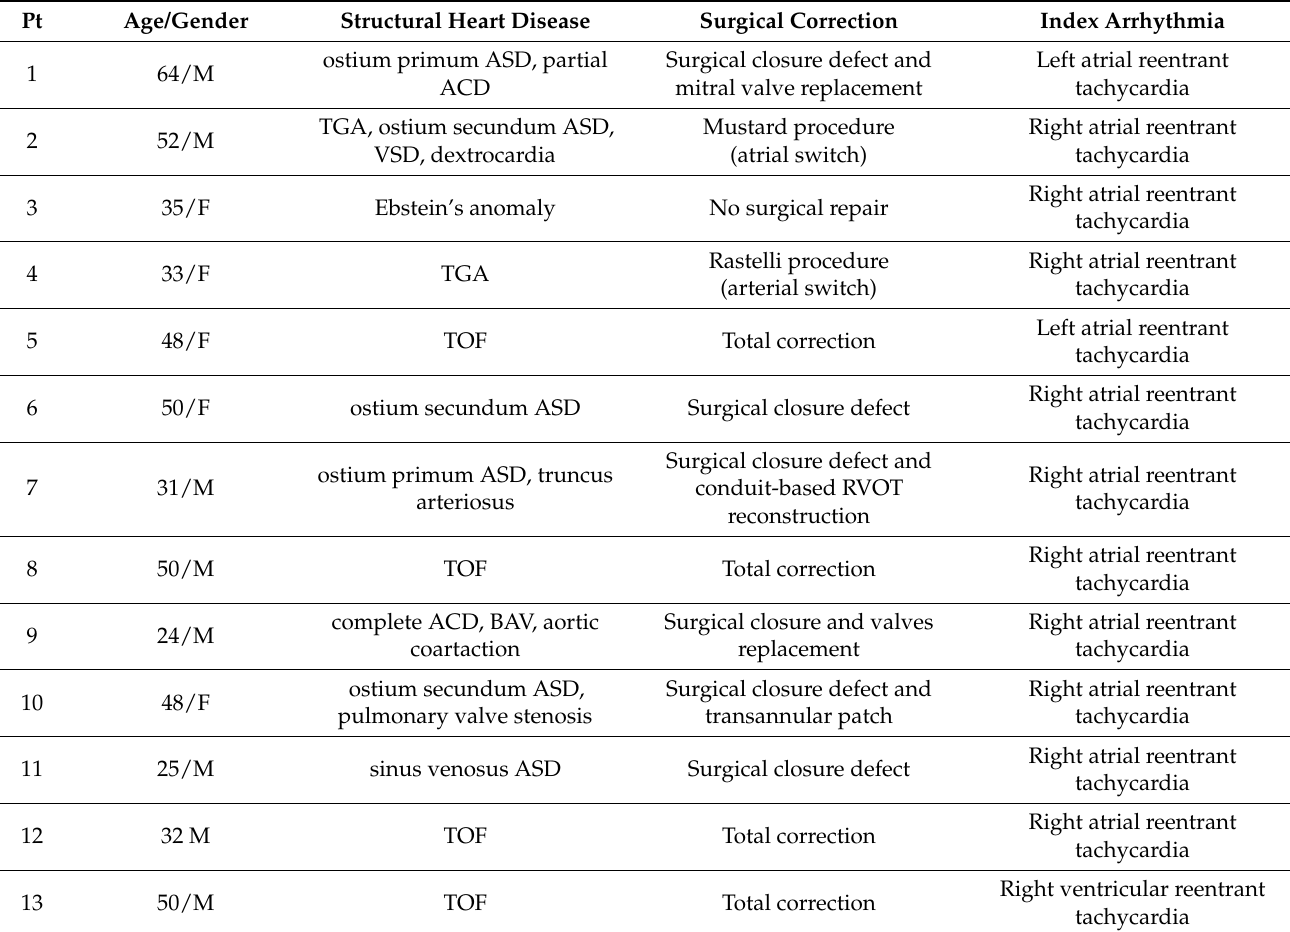
Table 1. Structural heart disease, surgical correction, and clinical arrhythmia of the enrolled